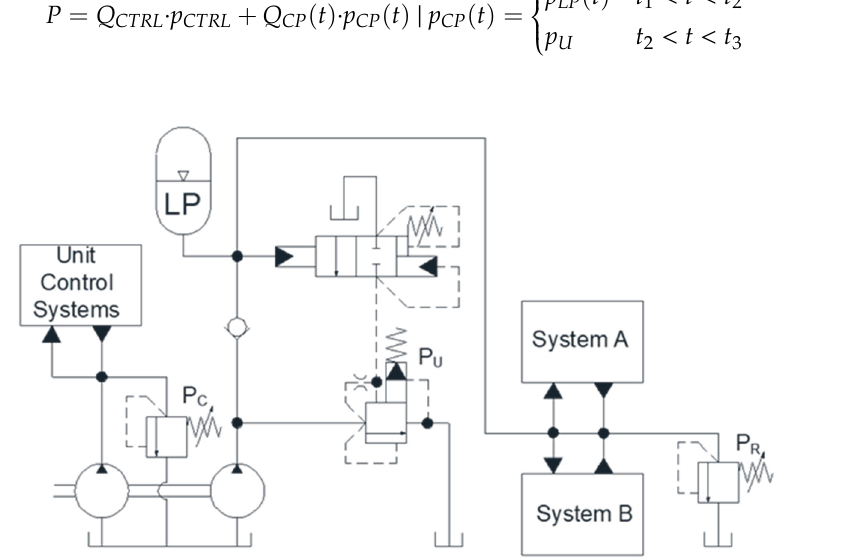
Figure 8. Proposed split LP system with ASPU valve.